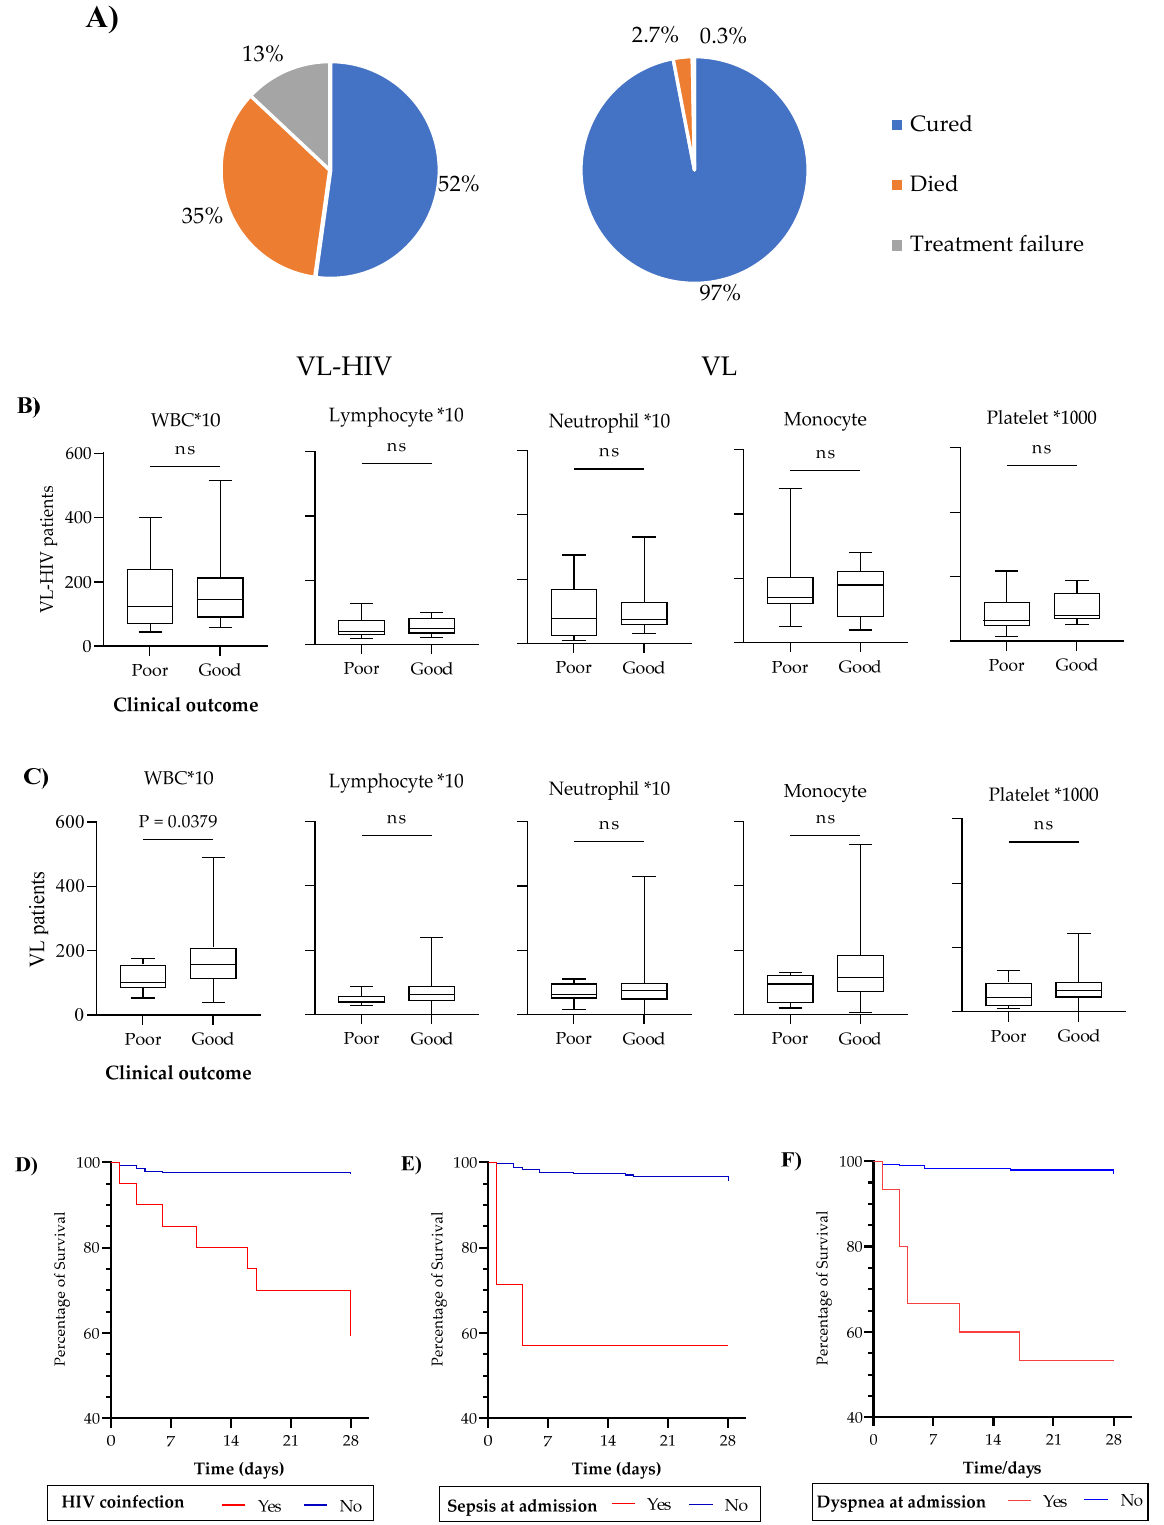
Figure 4. ( A ) End ‐ of ‐ treatment clinical outcomes, ( B , C ) leukocyte and platelet counts with respect to end ‐ of ‐ treatment clinical outcomes among VL patients with and without HIV coinfection. ns, statistically not significant. * 10, the presented cell count value should be multiplied by 10 to obtain the actual cell count. ns, not significant. ( D – F ) survival curves among VL patients with HIV, sepsis, and dyspnea, respectively. Table 3. Bivariate and multivariate analysis of predictors of poor clinical outcomes among VL pa ‐ tients during the time of admission at LRTC, Gondar, Ethiopia.